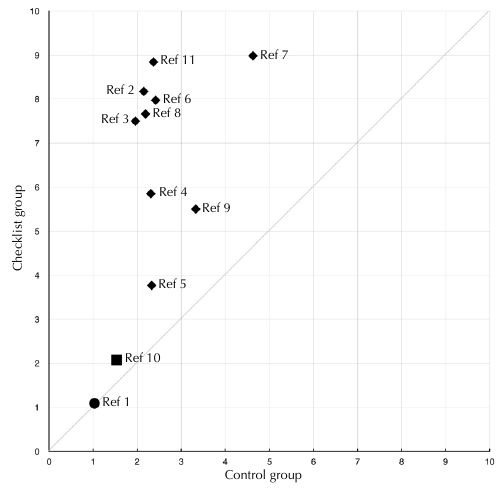
Figure 3. Statistical significance to anatomical references considered essential in the